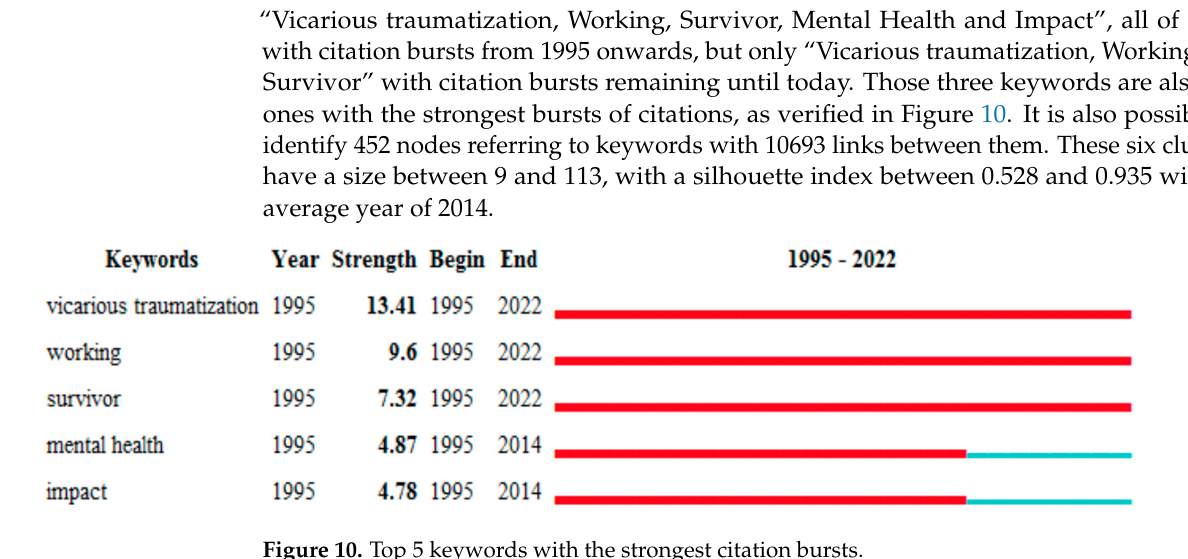
Figure 10. Top 5 keywords with the strongest citation bursts.